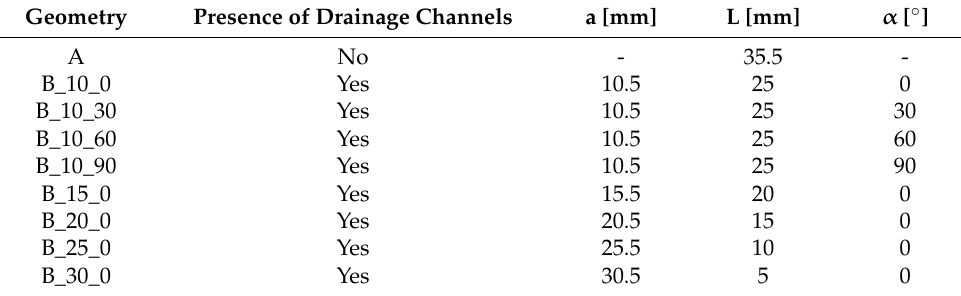
Table 1. Geometrical details of analysed mist-wave